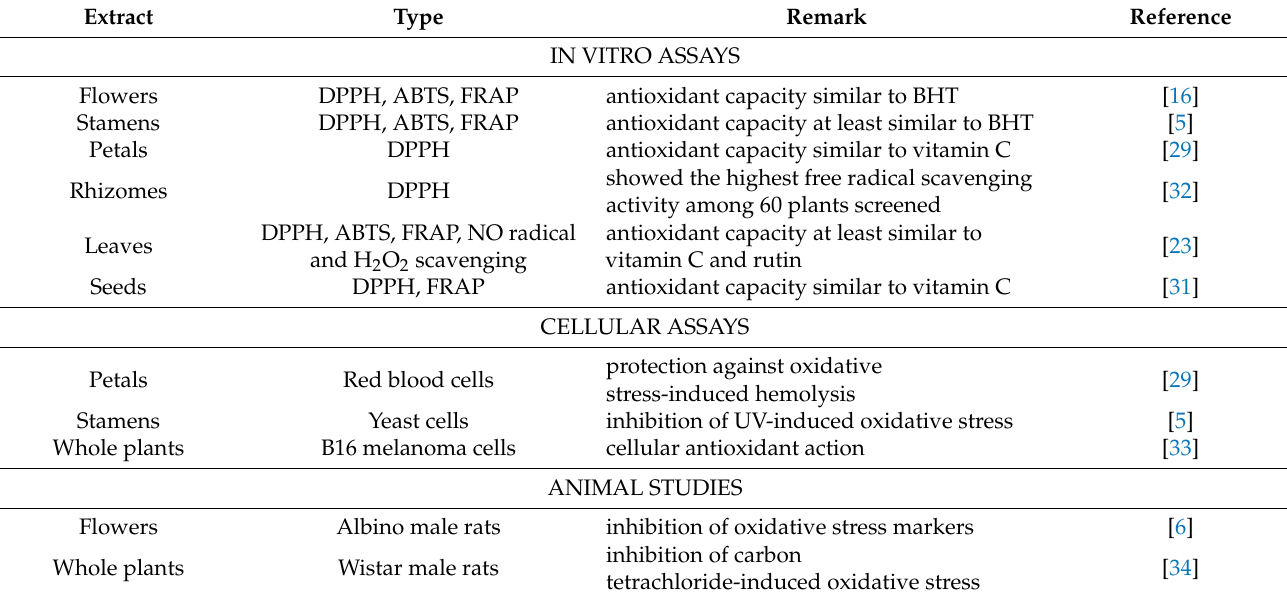
Table 1. Overview of the antioxidant activity of N. lotus